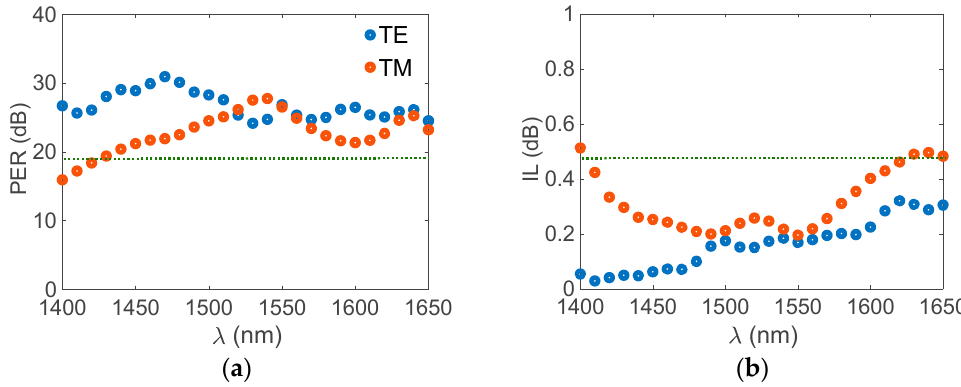
Figure 8. ( a ) PER and ( b ) IL versus wavelength at the same parameters as those in Figure 4. To show our design’s superiority, we compared its overall performance with that of